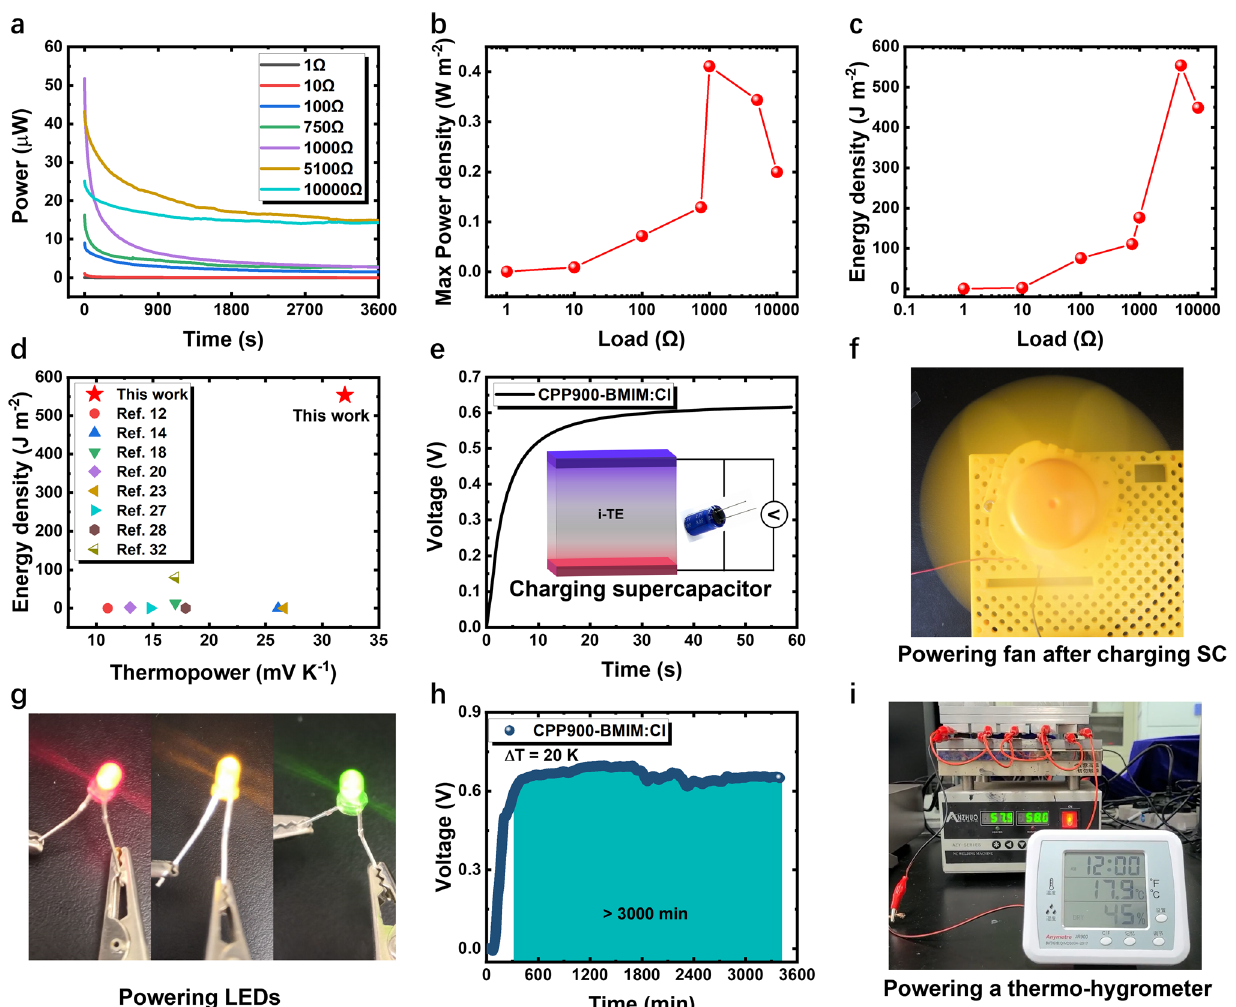
Fig. 4 a Power curves of CPP900-BMIM:Cl during discharging when connected to different external loads. The temperature difference is 20 K. Variation trend of b maximum output power and c energy density with external load. d Comparison of energy density of CPP900-BMIM:Cl with the optimal values reported in literatures. Because the test conditions for i-TE energy density are not uniform (discharge time, temperature difference, load resistance, relative humidity, etc.), we provide a rough comparison here to facilitate an understanding of the output limit and scale of i-TEs. e Charging curve of CPP900-BMIM:Cl for a 10 mF supercapacitor at a temperature difference of 20 K. f A fully charged superca- pacitor with a capacity of 0.5 F can drive a small fan directly. g Connecting 4 charged supercapacitors (10 mF) in series, the recovered heat can light up red, yellow and green light-emitting diodes. h The open-circuit voltage of CPP900-BMIM:Cl under a continuous temperature difference of 20 K. i Powering a thermo-hygrometer directly by a i-TE module without supercapacitors. (Color figure